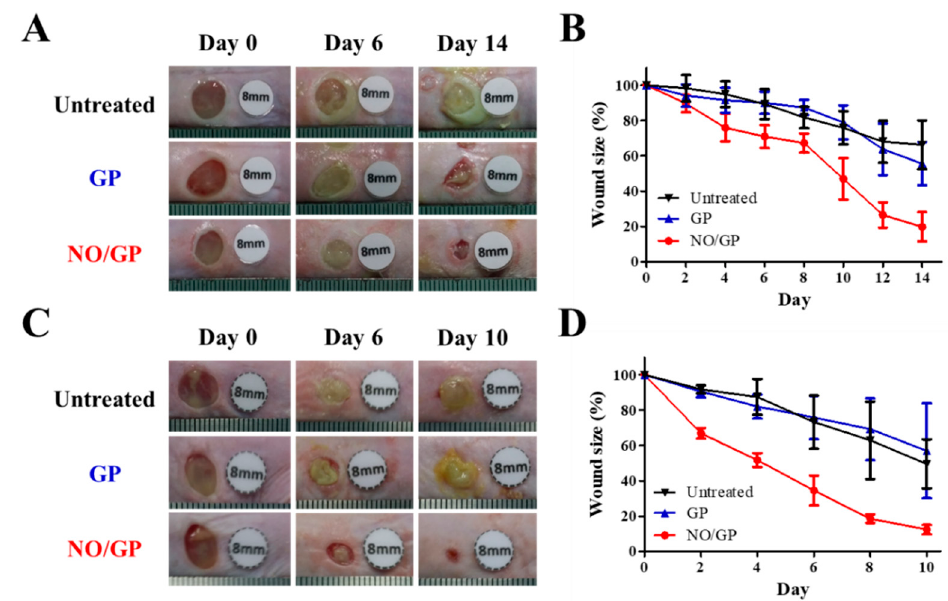
Figure 6. Representative macroscopic images of P. aeruginosa -challenged full-thickness wounds in mice 0, 6, and 14 days after treatment initiation ( A ). Changes in wound size in mice with P. aeruginosa -challenged full-thickness wounds ( B ). Representative macroscopic images of MRSA-challenged full-thickness wounds in mice 0, 6, and 14 days after treatment initiation ( C ). Changes in wound size in mice with MRSA-challenged full-thickness wounds ( D ). Values are presented as the mean ± standard deviation ( n = 4).